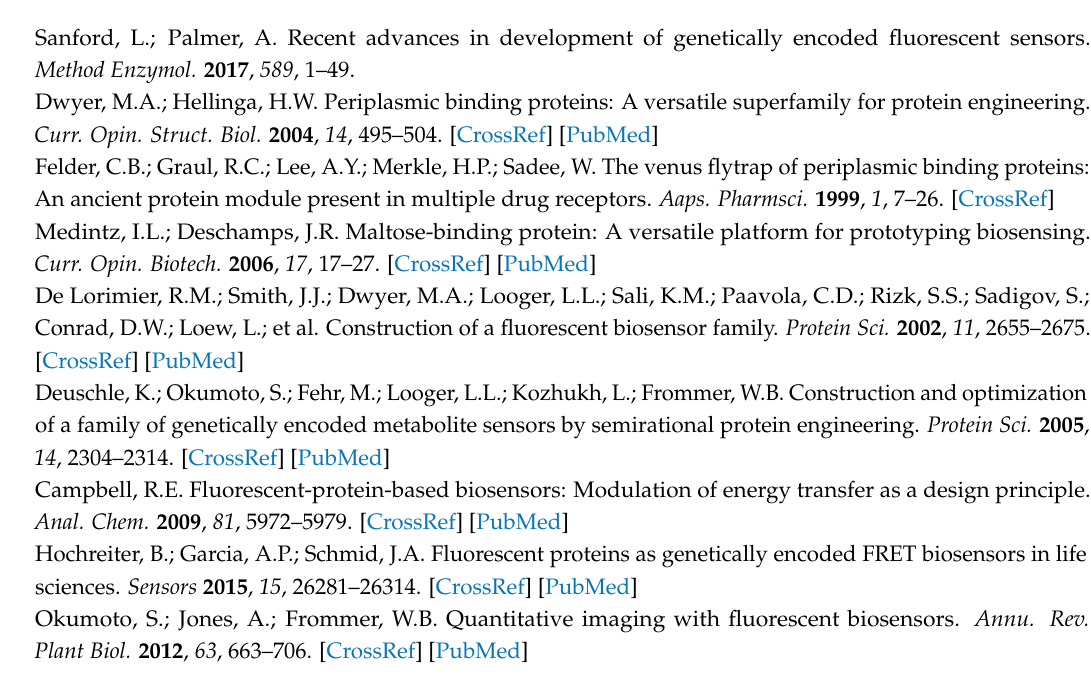
251 LAGTVLNDANNQAKATFDLAKNLADGKGAADGTNWKIDNKVVRVPYVGVD 301 KDNLAEFSKKHHHHHH Figure A1. Amino acid sequence of the MglB protein is given as used in this study. The two inserted cysteine residues at positions 42 and 137 are highlighted cyan and purple, respectively. The C-terminal His-tag is highlighted green.